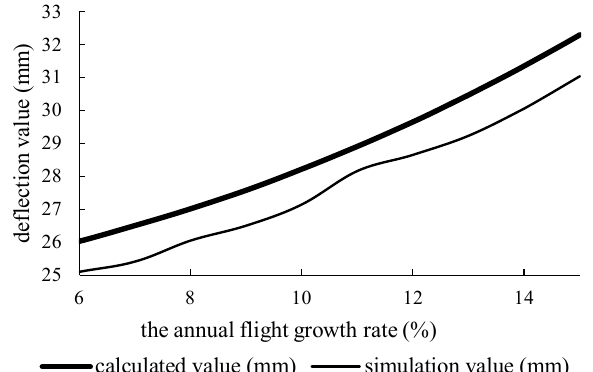
Figure 12. Data validation curve.